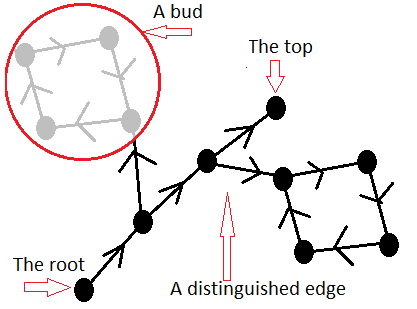
Figure 2: A cactus with two buds.